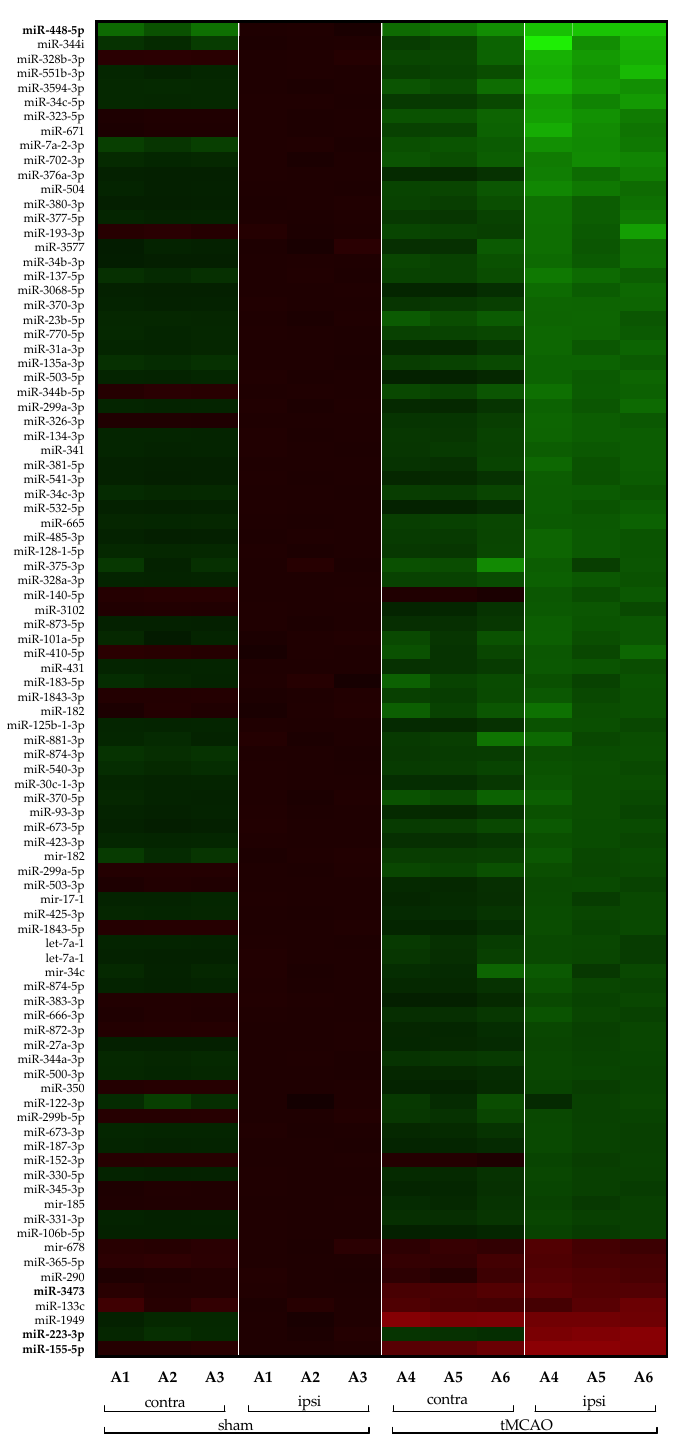
Figure A1. MicroRNA profiling using Affymetrix miRNA 4.0 Arrays. miRNAs with a fold-change of at least 1.5 compared to sham ipsi were considered differentially expressed. The heatmap was designed to show a 2-fold cut-off. Rows were normalized relative to the median. miRNA alteration is expressed from dark red (downregulated) to bright blue (upregulated). n = 3.